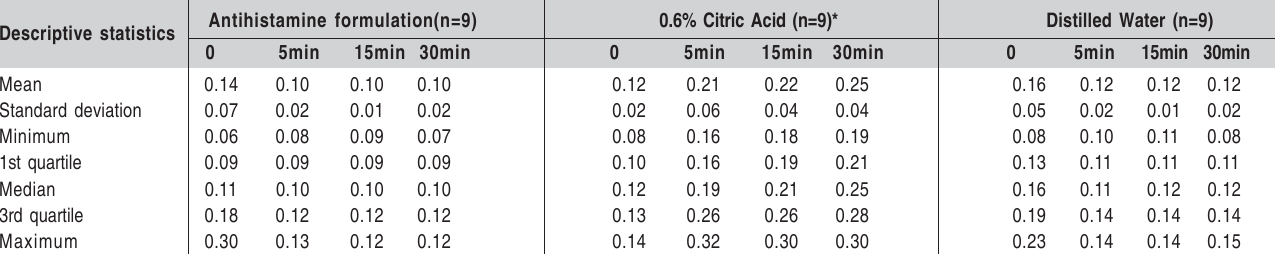
Table 2 – Descriptive statistics of roughness values (Ra – µm) by treatment groups and time intervals.